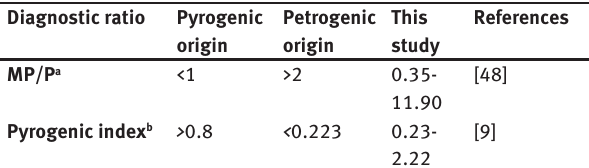
Table 2: The selected molecular ratios for discriminate between pyroletic and petrogenic